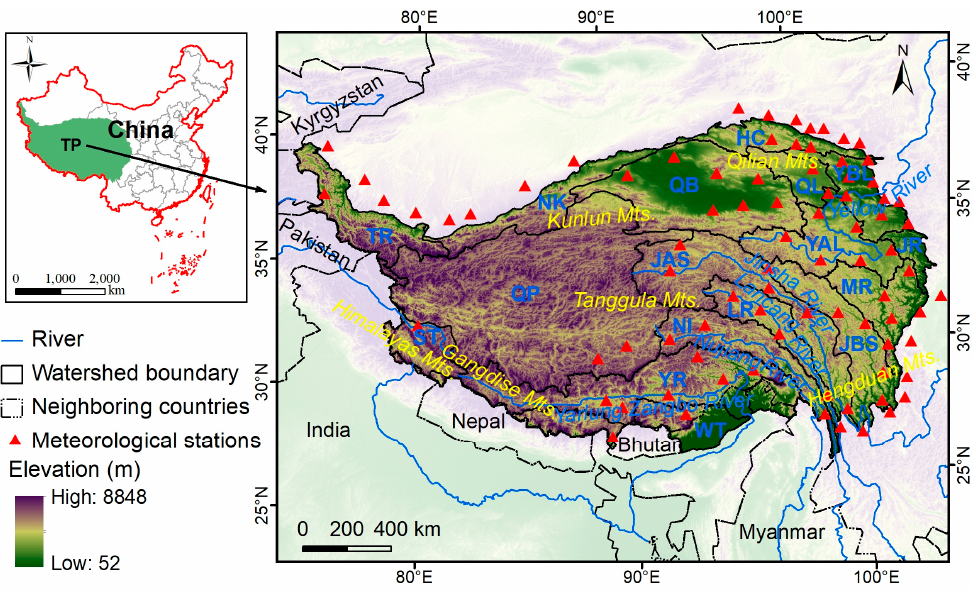
Figure 1. Geographical situation of the Tibetan Plateau.